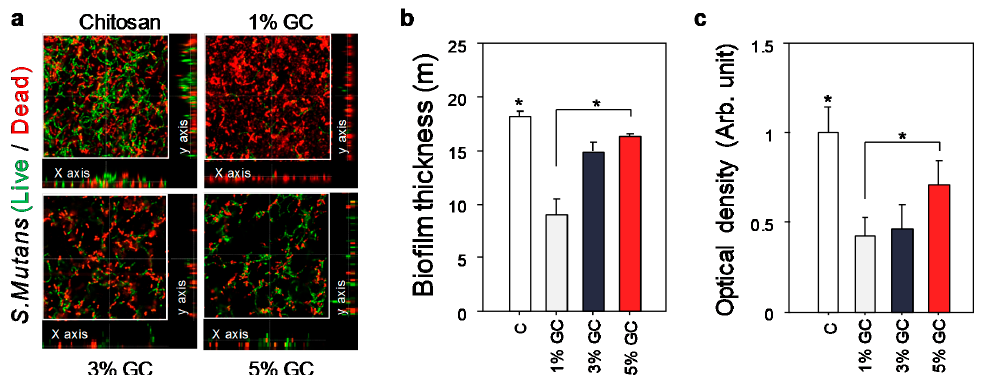
Figure 2. Effects of graphene–chitosan hybrid implants on bacteria activity. ( a ) Confocal microscopy images of S. mutans on graphene–chitosan hybrid implants (1%, 3%, and 5% GC) and the chitosan implant (C). Green fluorescence indicates viable cells and red fluorescence indicates dead cells ( n = 10 per group). ( b , c ) Quantification of biofilm thickness and optical density. The data were analyzed using one-way ANOVA (* p <